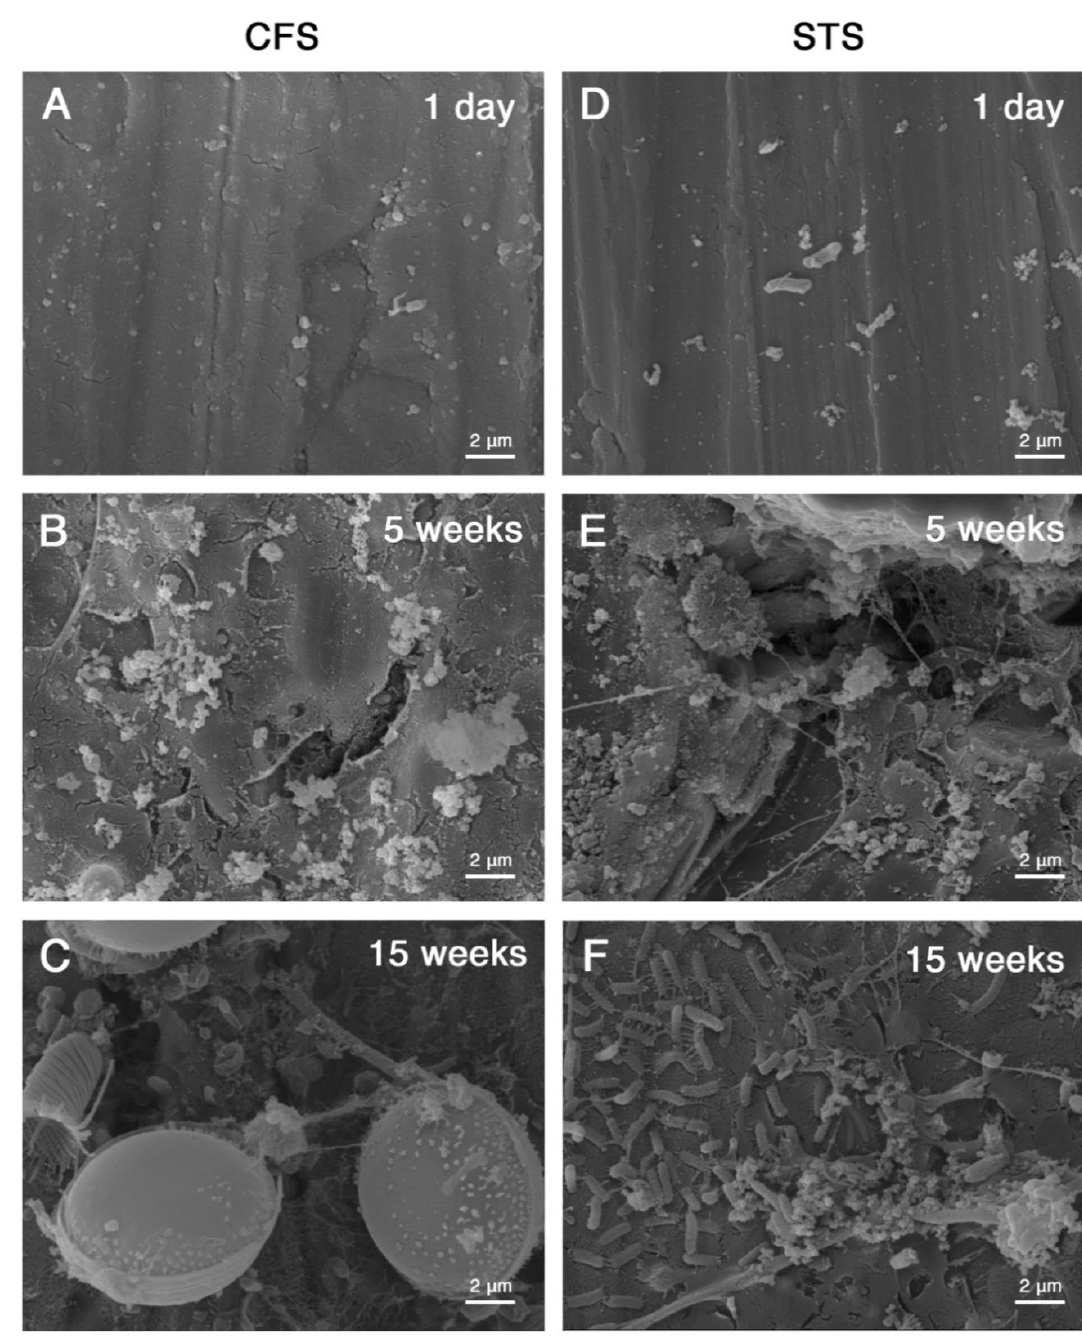
Figure 1. Scanning electron micrographs of the biofilms formed over stainless steel AISI 316L after exposure to natural seawater. ( A – C ) Continuous flow system (CFS) exposure, ( D – F ) stimulated tide system (STS) exposure. Images had scale bars of 2 µm that correspond to magnifications of 10,000×.